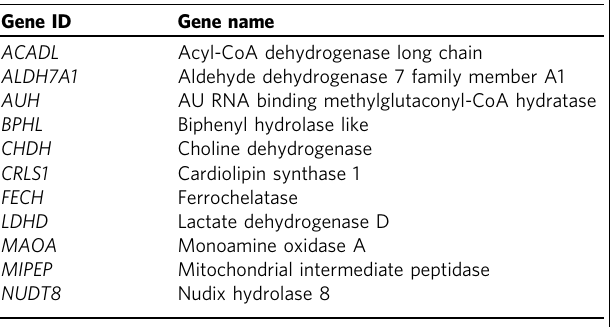
Table 2 Metagene signature of severe respiratory phenotype